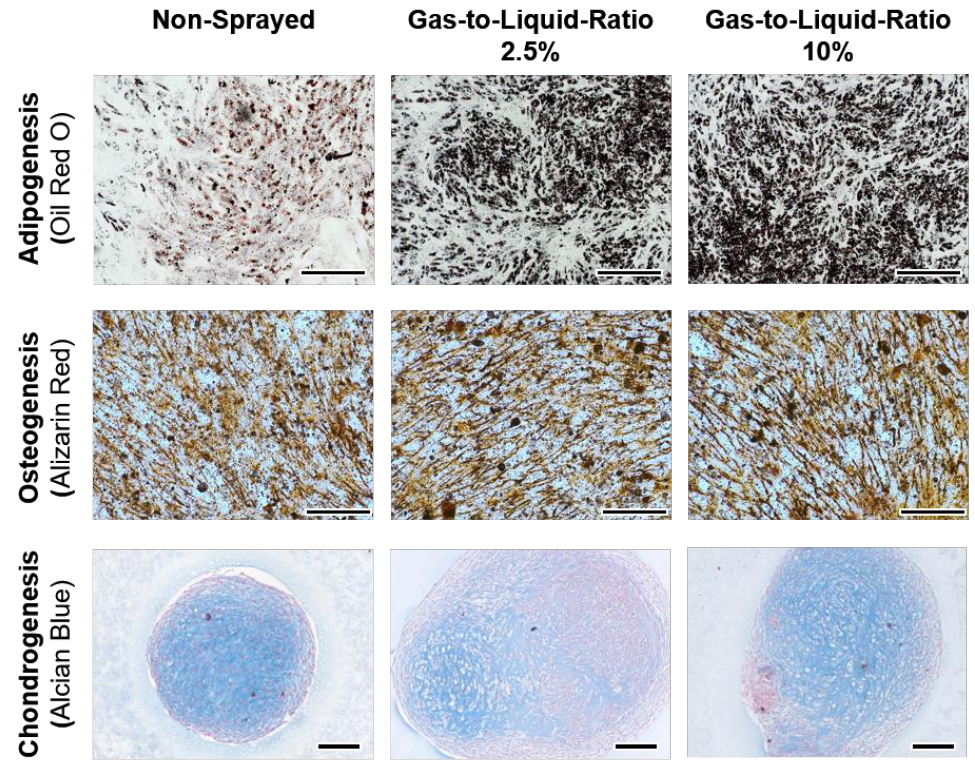
Figure 9. Non-sprayed and sprayed (gas-to-liquid ratio 2.5% and 10%) ASCs after tri-lineage entiation into adipocytes (top row), osteocytes (middle row, scale bars: 500 µ m), and chondrocytes differentiation into adipocytes (top row), osteocytes (middle row, scale bars: 500 µm), and chondrocytes (bottom row, scale bar: 200 µm). (bottom row, scale bar: 200 µ